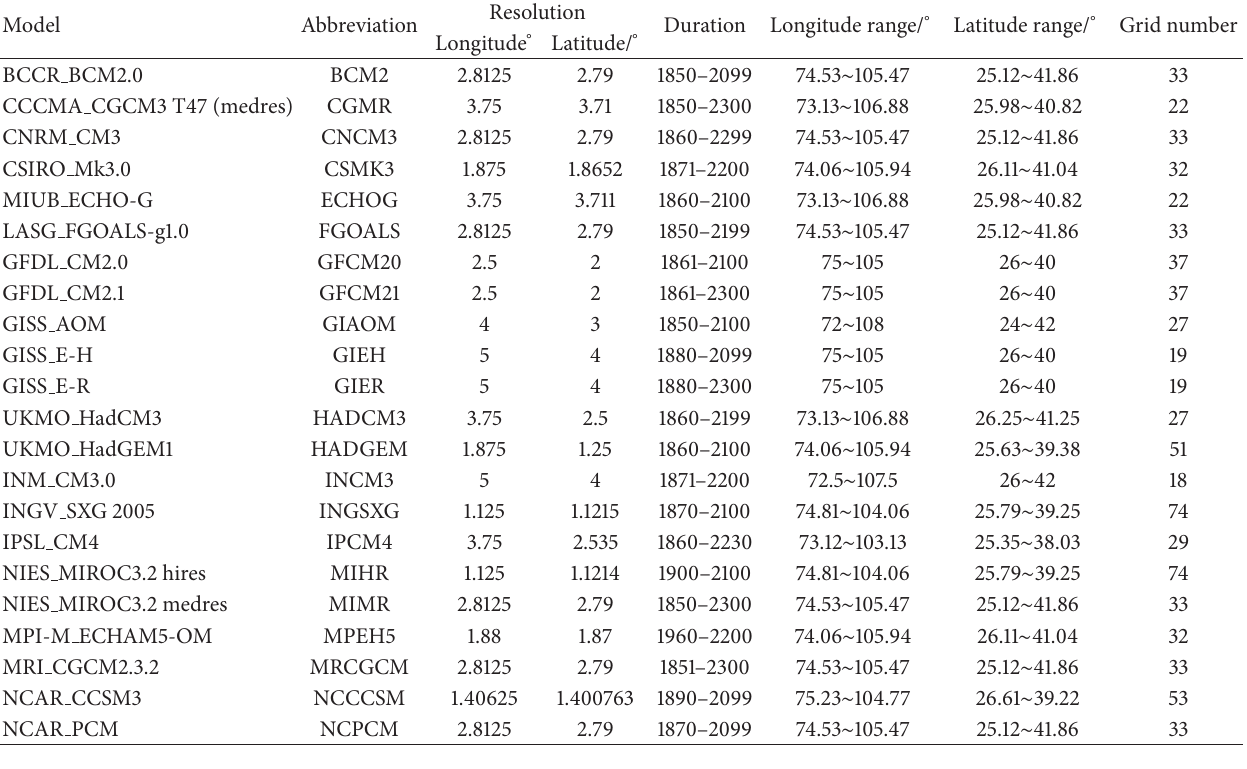
Table 1: Information of 22 climate models of IPCC AR4 and boundary configuration on the Tibetan Plateau.